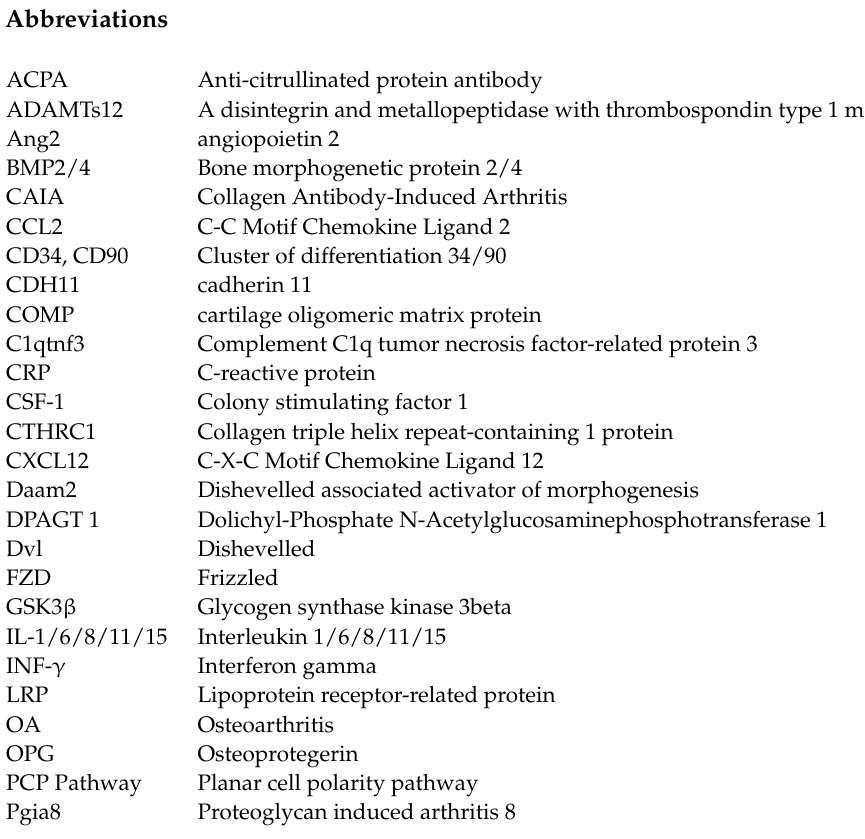
figure conceptualization and preparation, editing; S.L.: writing—original draft preparation; J.K.: conceptualization; writing—original draft preparation, editing and revision, funding acquisition. All authors have read and agreed to the published version of the manuscript. Funding: This work was funded by a Nazarbayev University research award (Project ID 16135673, award number 064.01.01 SST 2016022 awarded to